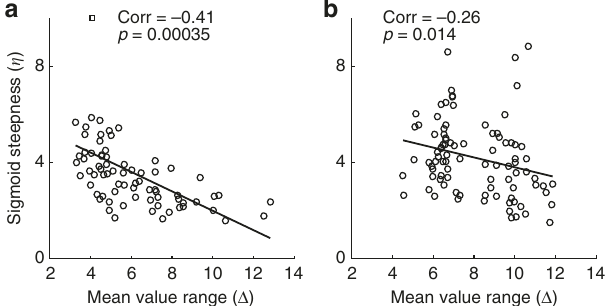
Fig. 6 Relation between sigmoid steepness and value range, scatter plots. a , b . Panels a and b refer to monkey V (73 sessions) and monkey L (91 sessions), respectively. In each panel, the x -axis represents the geometric mean value range Δ ≡ ( ρ Q A Q B ) 1/2 , the y -axis represents the steepness of the sigmoid ( η ) and each data point represents one session. In both animals, the two measures were signi fi cantly and negatively correlated. In each panel, the black line represents the result of Deming ’